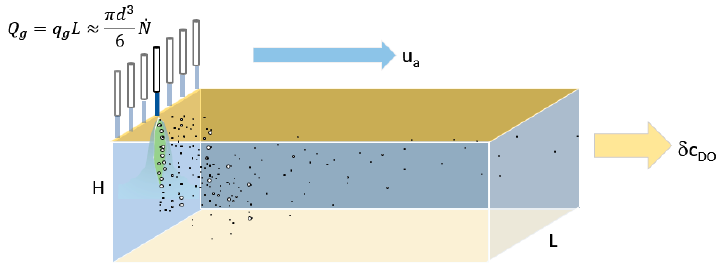
Figure 8. Schematic of model used to calculate the increase of dissolved oxygen concentration in a flux of water. An example single plunging jet in an array of 7 jets ( n = 7) shown. The increase in dissolved oxygen concentration in the water column (cid:2012) (cid:3004)(cid:3005)(cid:3016) (mass/volume) can be calculated as the oxygen flux (cid:1836) divided by the water flux, or: